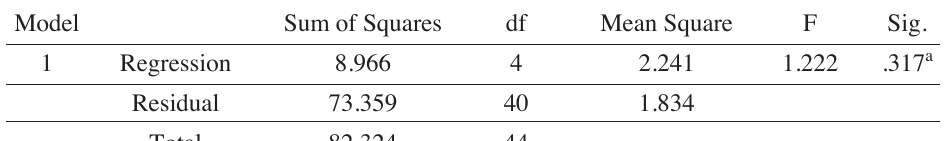
Table 8: Analysis of Variance